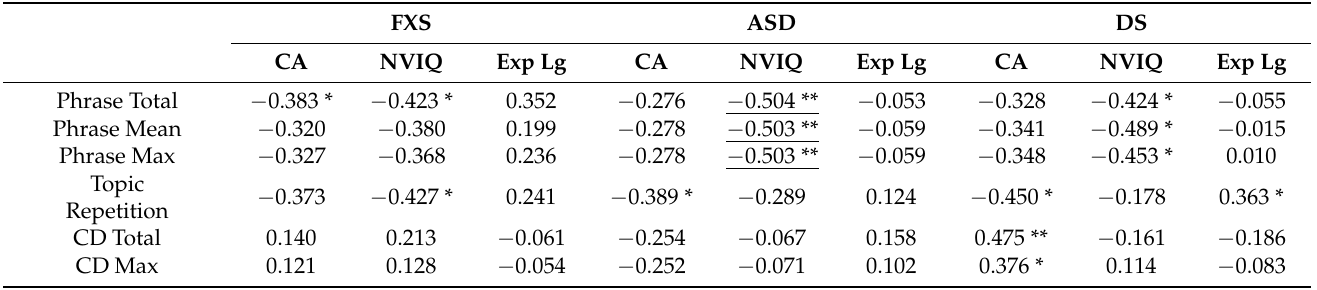
Table 5. Correlations between repetition measures and NVIQ, expressive language and chronological age controlling for number of C-units.